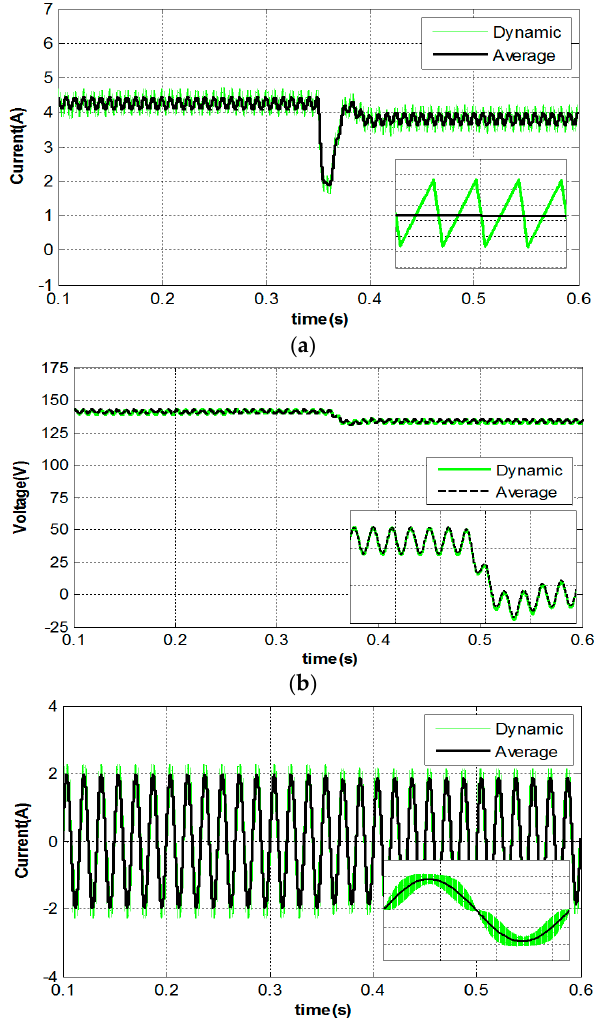
Figure 8. Simulation results for a single microinverter under open-loop control with resistive load. ( a ) PV current; ( b ) dc-bus voltage; ( c ) ac output current.